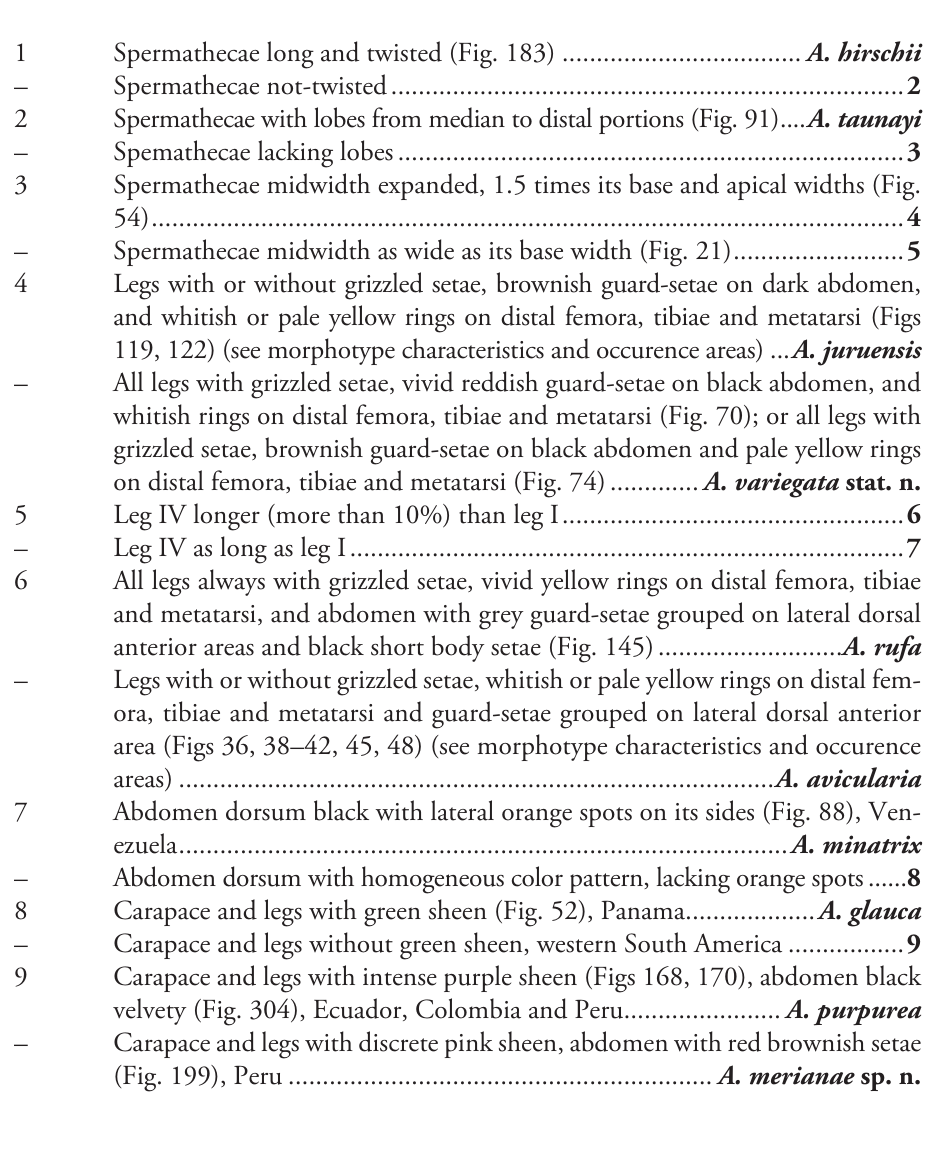
Spermathecae midwidth expanded, 1.5 times its base and apical widths (Fig. Spermathecae midwidth as wide as its base width (Fig. 21) ......................... 5 4 Legs with or without grizzled setae, brownish guard-setae on dark abdomen, and whitish or pale yellow rings on distal femora, tibiae and metatarsi (Figs 119, 122) (see morphotype characteristics and occurence areas) ... A. juruensis – All legs with grizzled setae, vivid reddish guard-setae on black abdomen, and whitish rings on distal femora, tibiae and metatarsi (Fig. 70); or all legs with grizzled setae, brownish guard-setae on black abdomen and pale yellow rings on distal femora, tibiae and metatarsi (Fig. 74) ............. A. variegata stat. n.